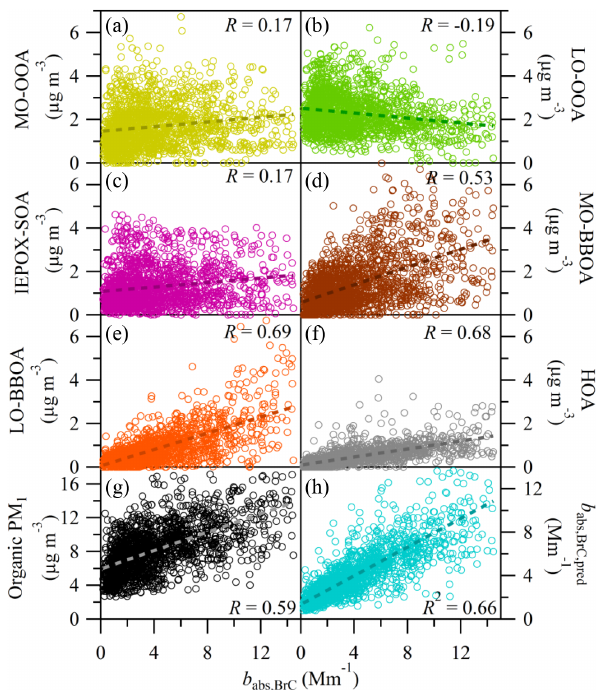
Figure 14. Scatter plots against b abs , BrC of (a) – (f) PMF factor load- ings, (g) organic PM 1 mass concentration, and (h) b abs , BrC , pred val- ues predicted by a multivariate linear regression model using PMF factor loadings as parameters as described by Eq.